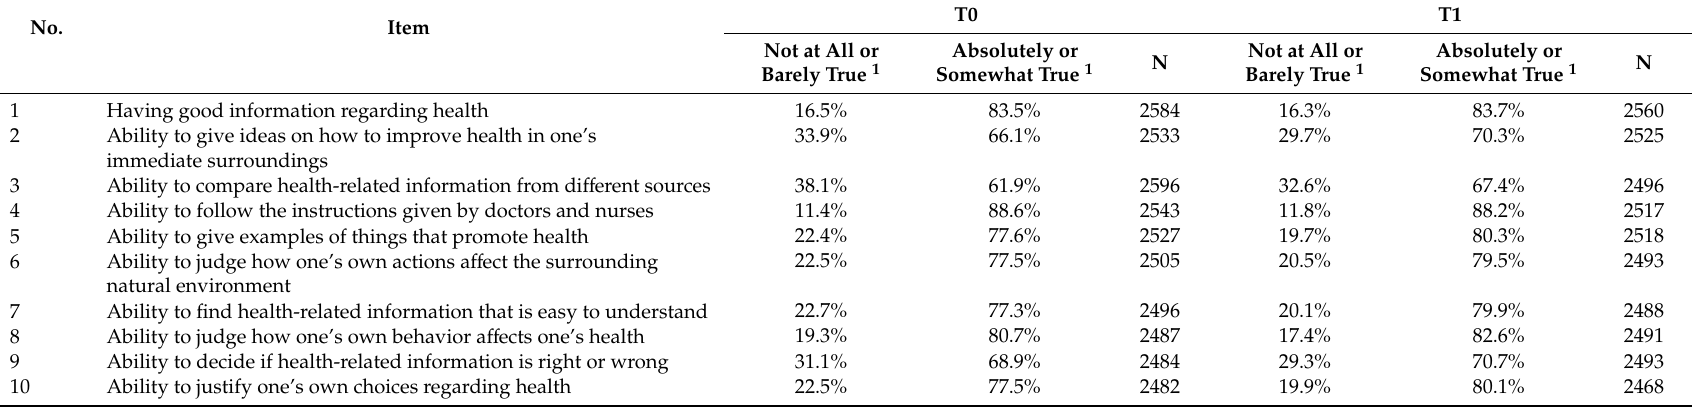
Table 4. Health Literacy for School-Aged Children (HLSAC) Matrix Items (children 11 years and older, T0 and